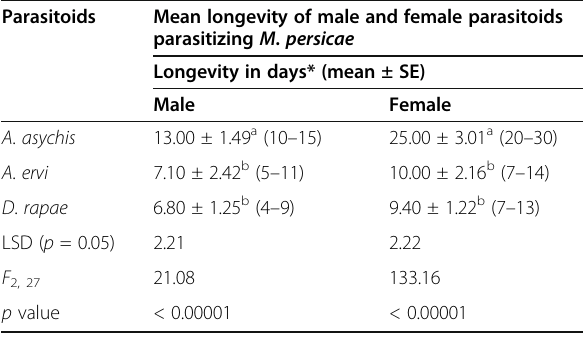
Figures in parentheses indicate range Mean values within the columns bearing the same letters are not significantly different — LSD ( p = 0.05) *All values are mean of 10